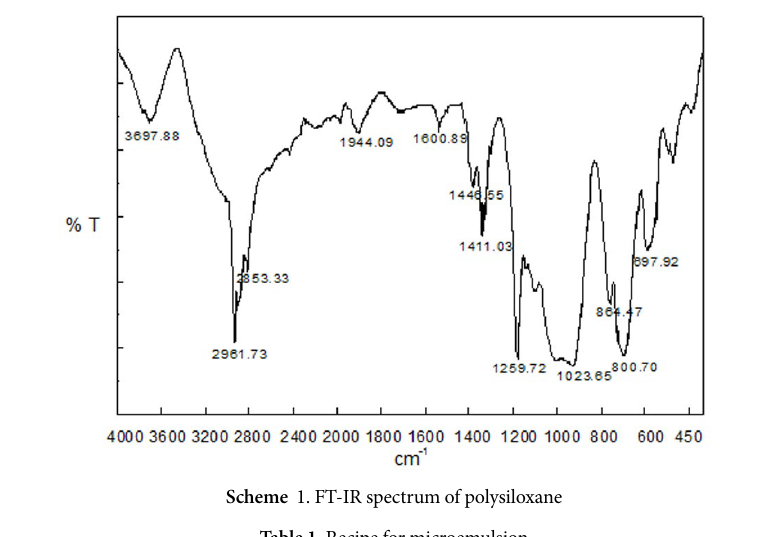
Table 1. Recipe for microemulsion Materials Amounts of the materials Catalyst on the gross weight of